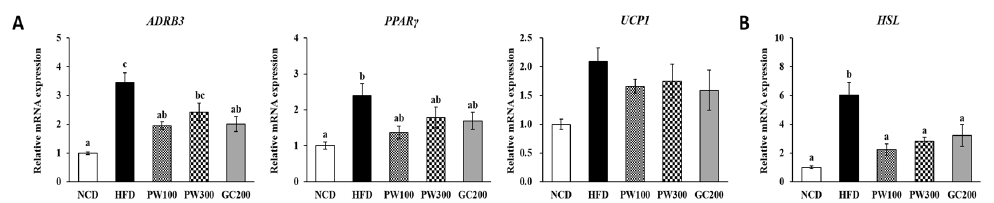
Plants 2021 , 10 , x FOR PEER REVIEW Figure 3. Effects of Polygonum multiflorum Thunb. hot water extract on thermogenic ( A ) and lipolytic ( B ) gene expressions in interscapular BAT in HFD-induced obese mice. Data are expressed as means ± SE. Values with different superscript letters are significantly different at p < 0.05 as determined by one-way ANOVA followed by Tukey’s HSD test.